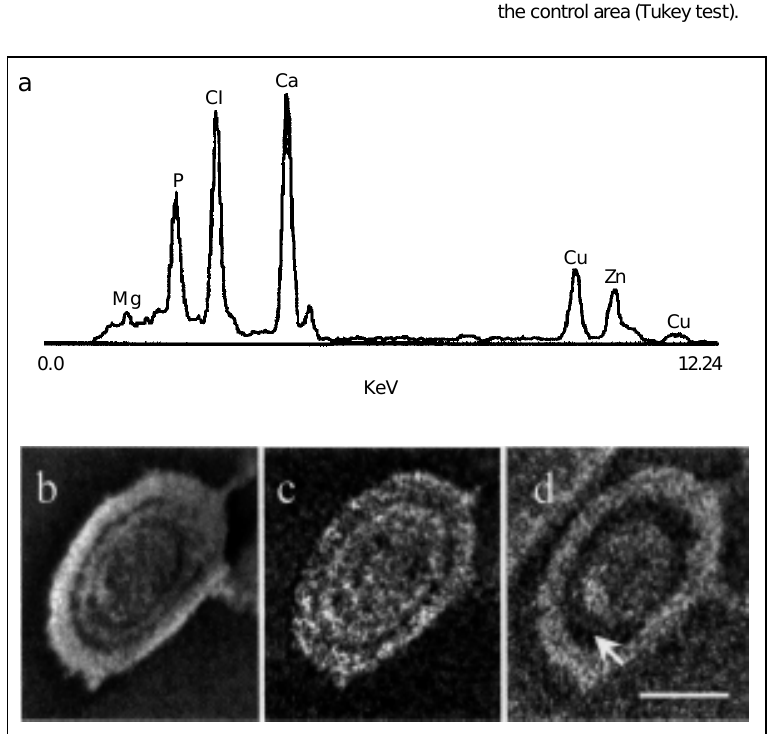
Figure 1 - Zinc concentration in the hepatopancreas of U. corda- tus crabs from the contaminated areas of Guanabara Bay and Sepetiba Bay, and from a non- contaminated area of Ribeira Bay. Data are reported as means ± SD for 10 crabs from each area. The hepatopancreatic zinc con- centration found for the con- taminated areas was significant- ly higher ( * P<0.05) compared to the control area (Tukey test).